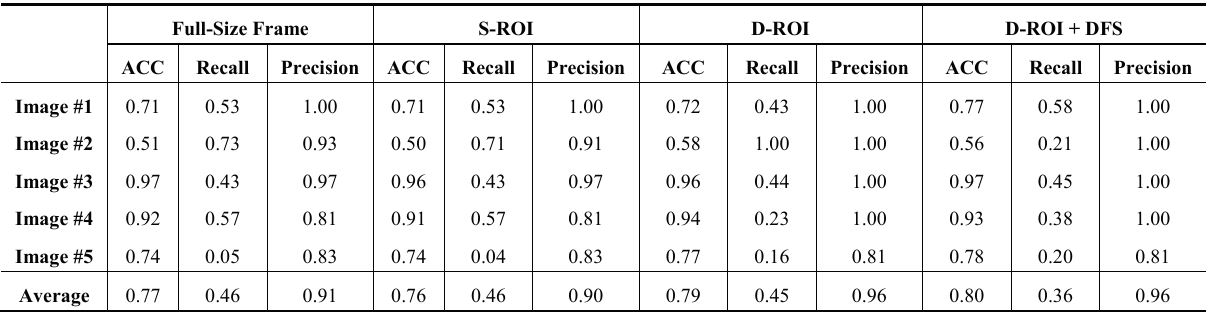
Table 7. Comparison of recognition accuracy, recall, and precision for the proposed methods (pedestrian recognition).